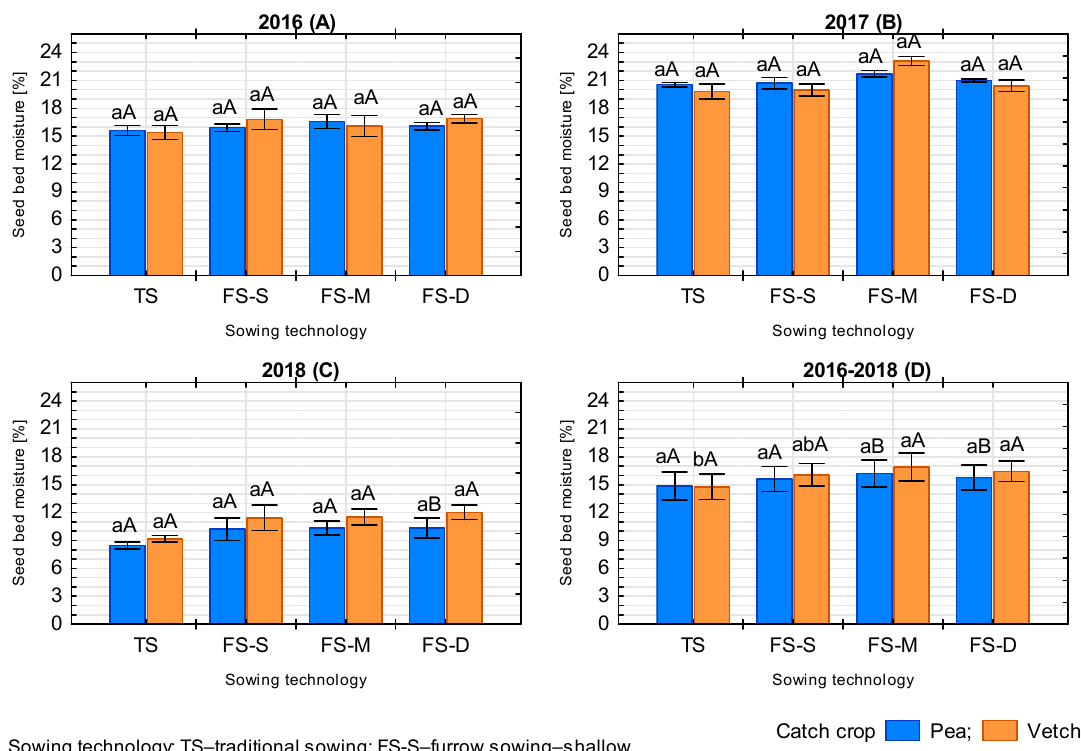
Figure 5. Seedbed moisture three days after sowing the seeds [% vol]. a,b—homogenic groups HSD ( p = 0.05) interaction for sowing method/species (the differences between the four methods of sowing separately for pea and for vetch). A,B—homogenic groups HSD ( p = 0.05) interaction for species/sowing method (differences between pea and vetch for each sowing method).